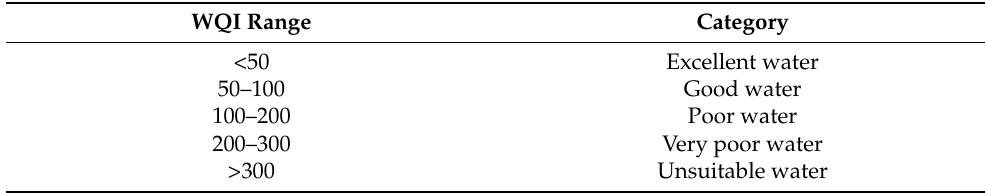
Table 6. Classification of the water quality index (WQI).